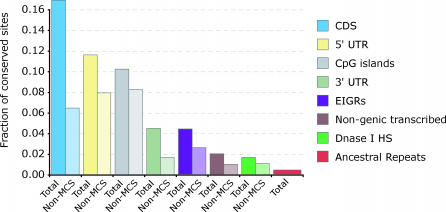
Conservation in Various Functional ClassesFor each functional class, the fraction of positions with SCONE p-value ≤ 0.005 is shown, both including (dark) and excluding (light) positions falling within MCS elements. Ancestral repeats are included as a control.